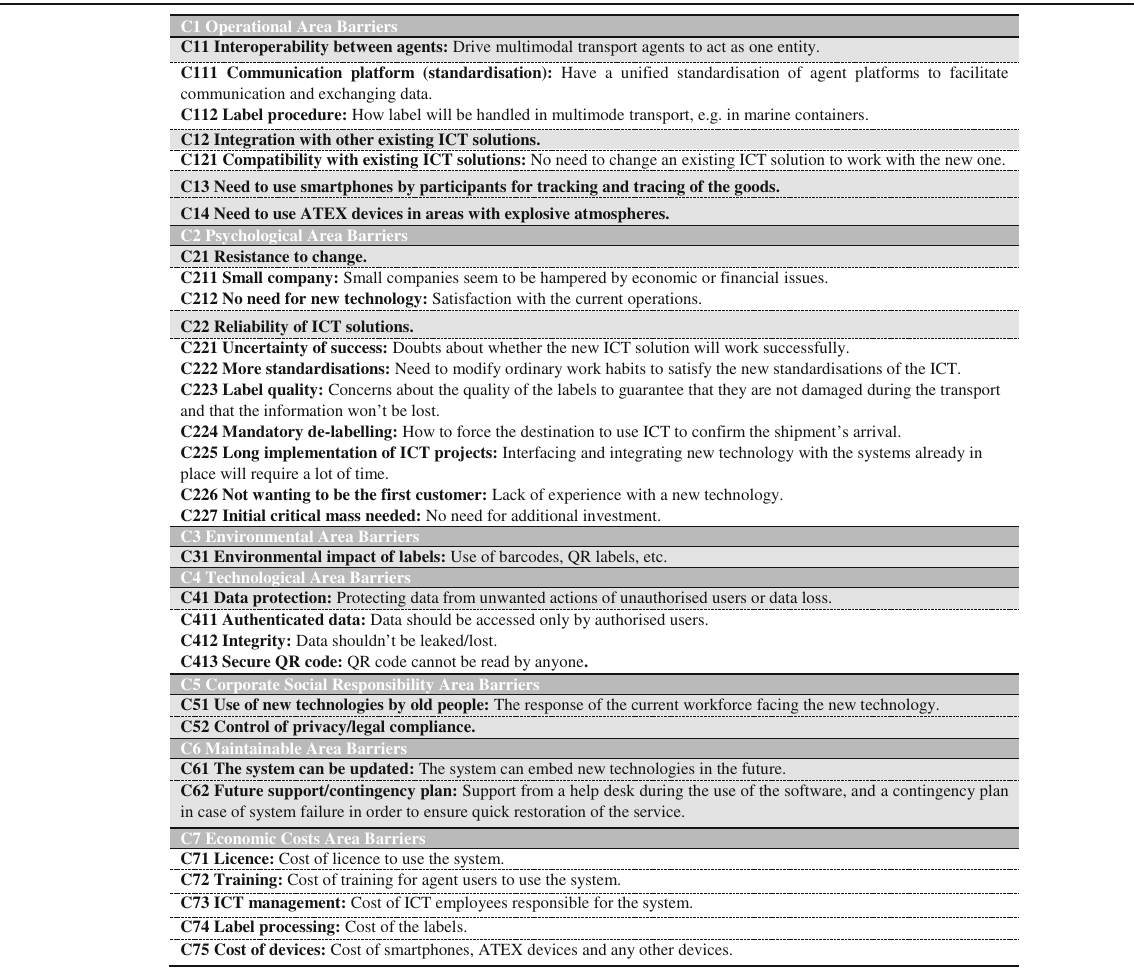
Table 3 Description of first-level barriers (dark grey), second-level barriers (light grey) and third-level barriers (white) for the implementation of an ICT solution for the TDG